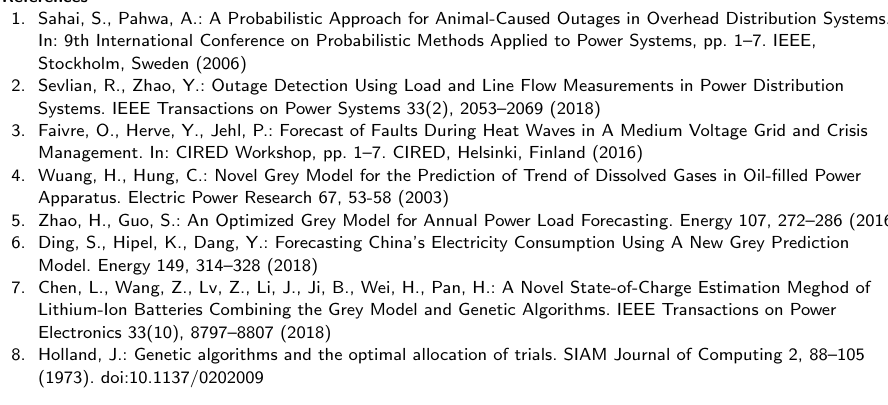
for a stronger power grid. The parameters for building the traditional grey model GM(1,1) is (cid:12)rst improved with the optimization techniques. Since the monthly out- age number is a seasonal data sequence, the rolling mechanism is introduced to improved the ability of capturing the change of